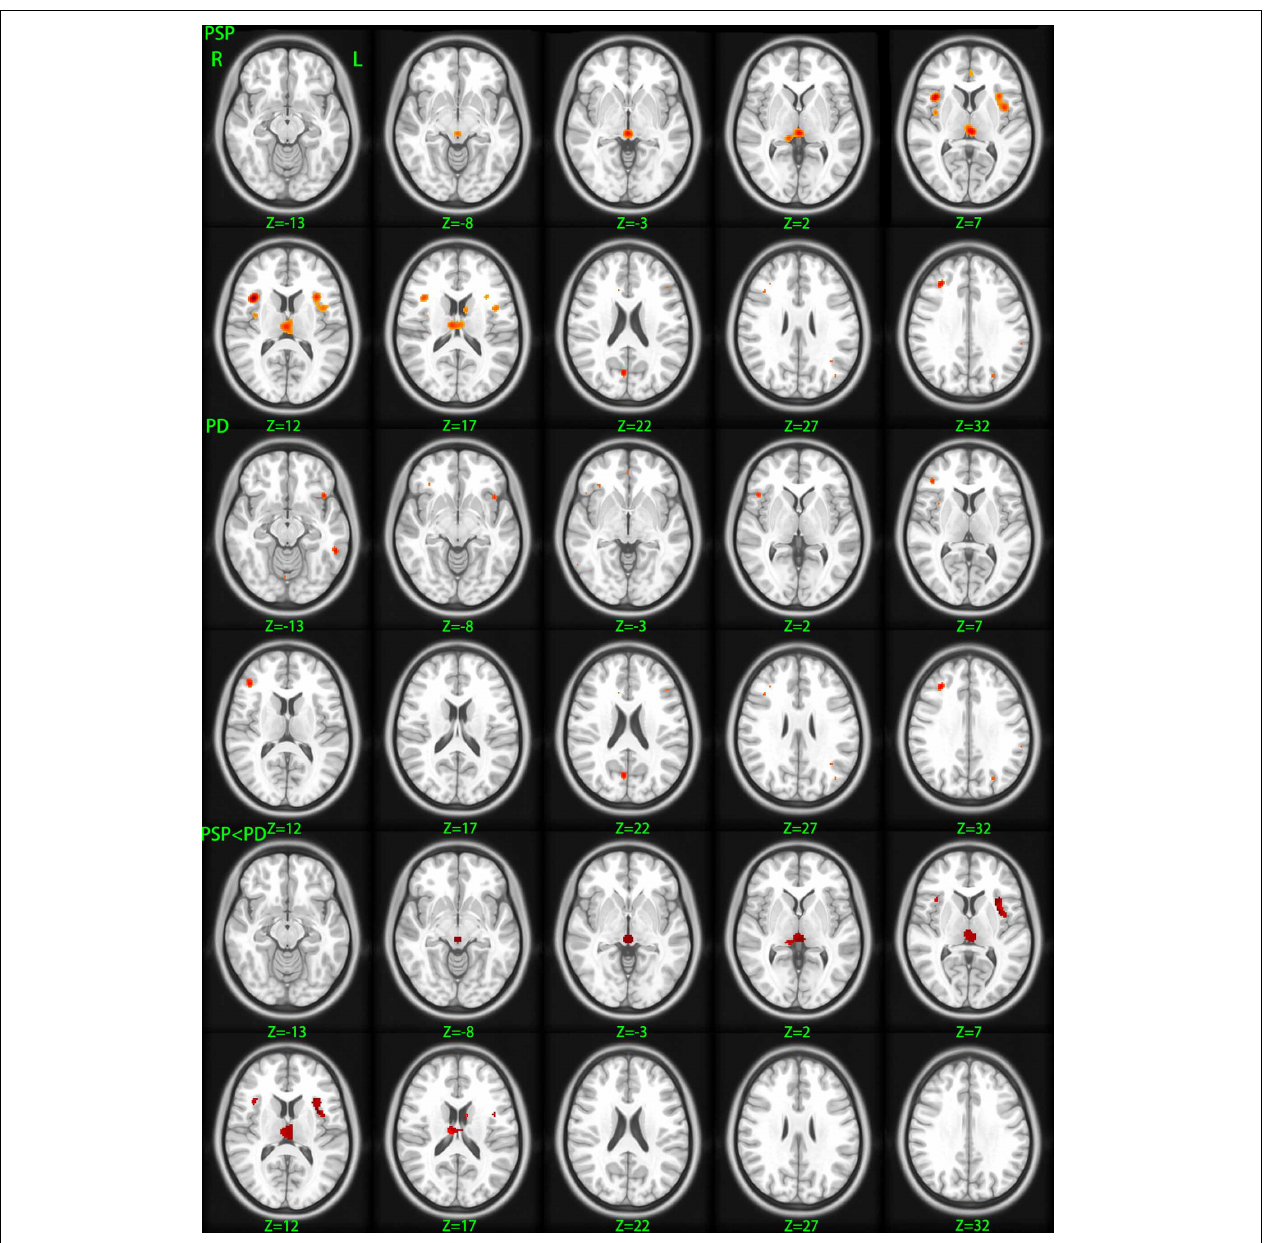
FIGURE 2 | Gray matter volume changes betweeen different groups. PSP, gray matter decreases in patients with progressive supranuclear palsy relative to healthy control; PD, gray matter decreases in patients with Parkinson’s disease relative to healthy control; PSP < PD, diminished gray